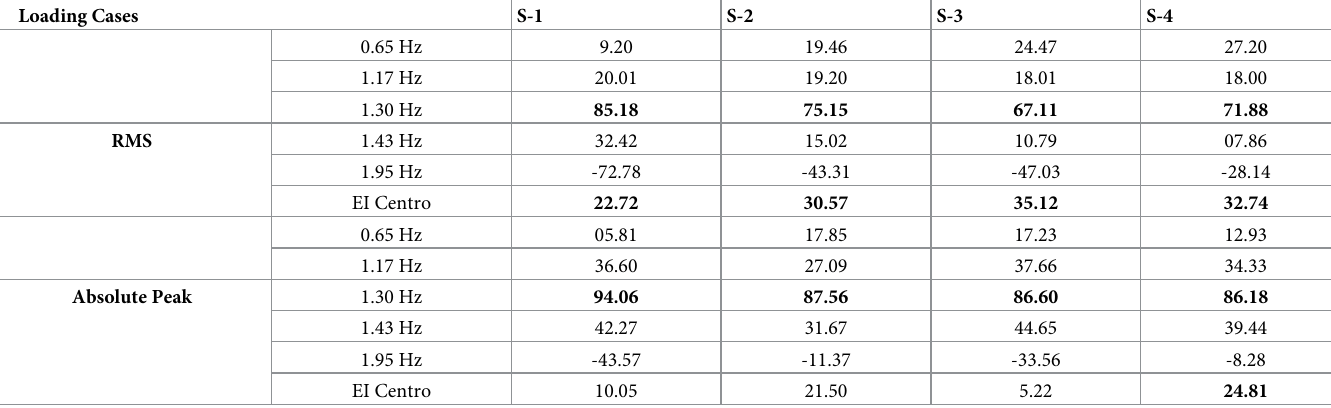
Table 4. Percentage reduction in the responses of MDOF structure with TLCD over uncontrolled MDOF structure. Loading Cases